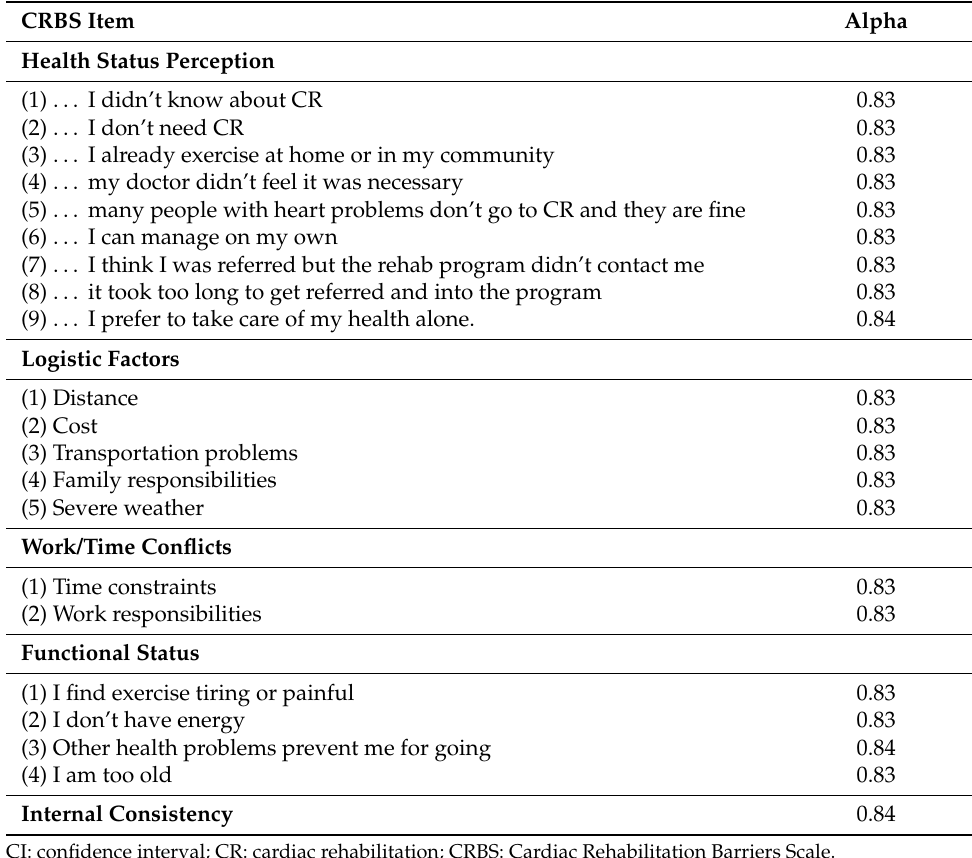
Table 2. Cardiac Rehabilitation Barriers Scale (CRBS) internal consistency.